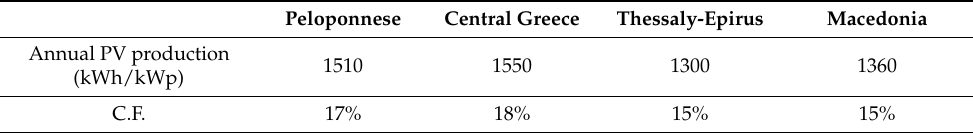
Table 3. Annual PV production [44].